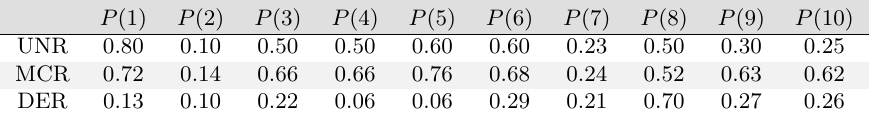
Table 4: Marginal probabilities for the 10 × 10 system.